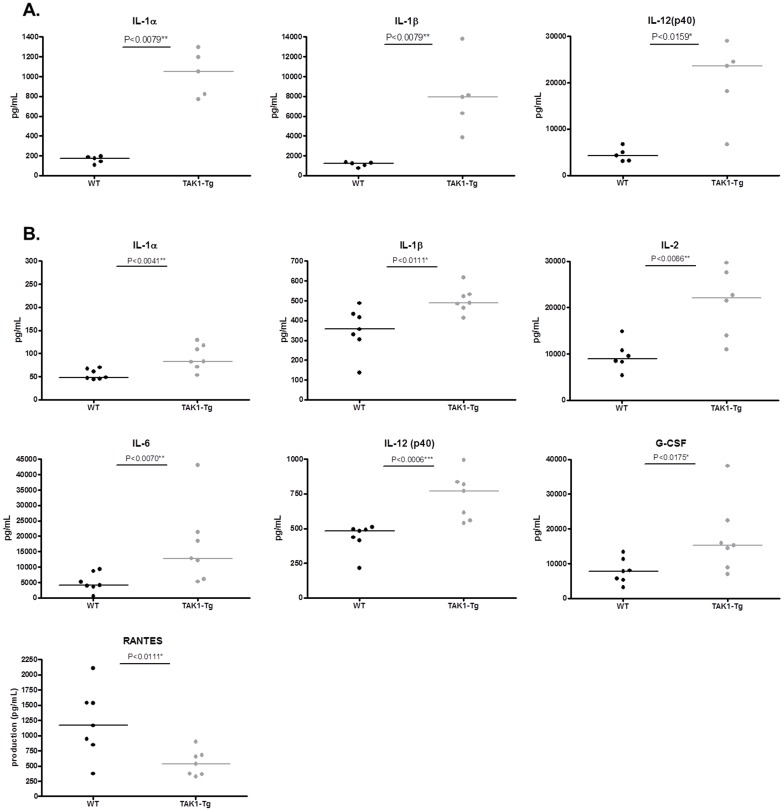
TAK1 knockdown exacerbates acute inflammation.Wildtype (WT) and TAK1 shRNA transgenic mice (TAK1-Tg) were treated with 0.2 mg/ml doxycycline in the drinking water for five weeks. Acute inflammation was induced by administration of LPS (n = 5 each group) (A) or anti-CD3 antibodies (n = 8 each group) (B) in the peritoneal cavity. After 1.5 or 3 hours, respectively mice were sacrificed and circulating levels of cytokines and chemokines were detected by Multiplex and are represented in pg/ml. Statistical significance was determined using the Mann-Whitney test (p<0.05). Data are representative of at least two independent experiments.